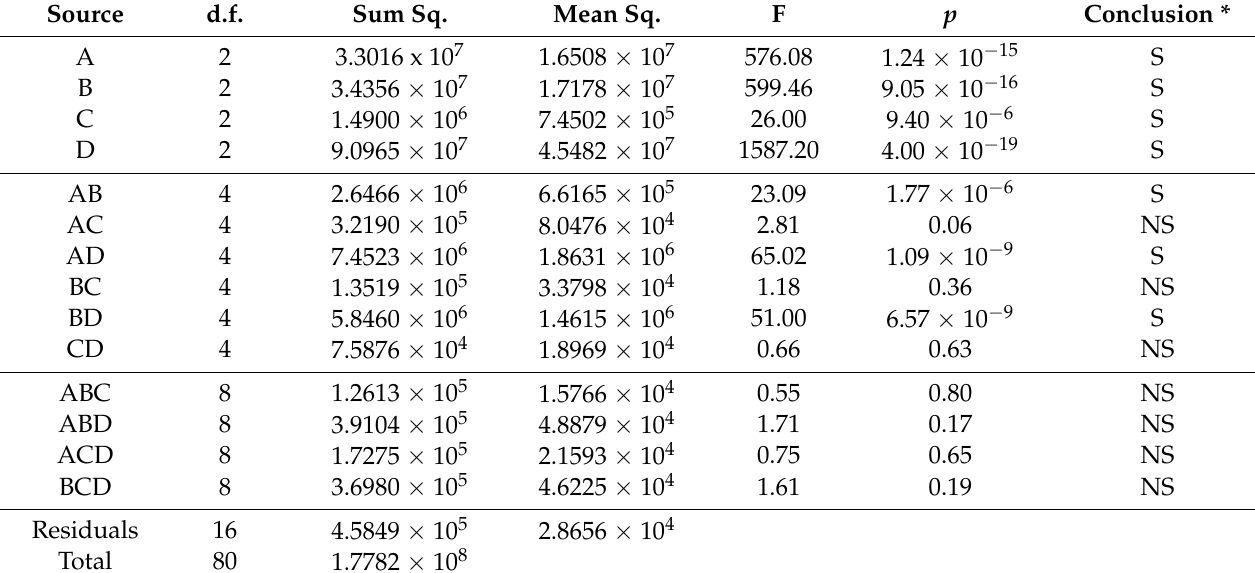
Table 4. Modulus of elasticity Rresults for the four-factor